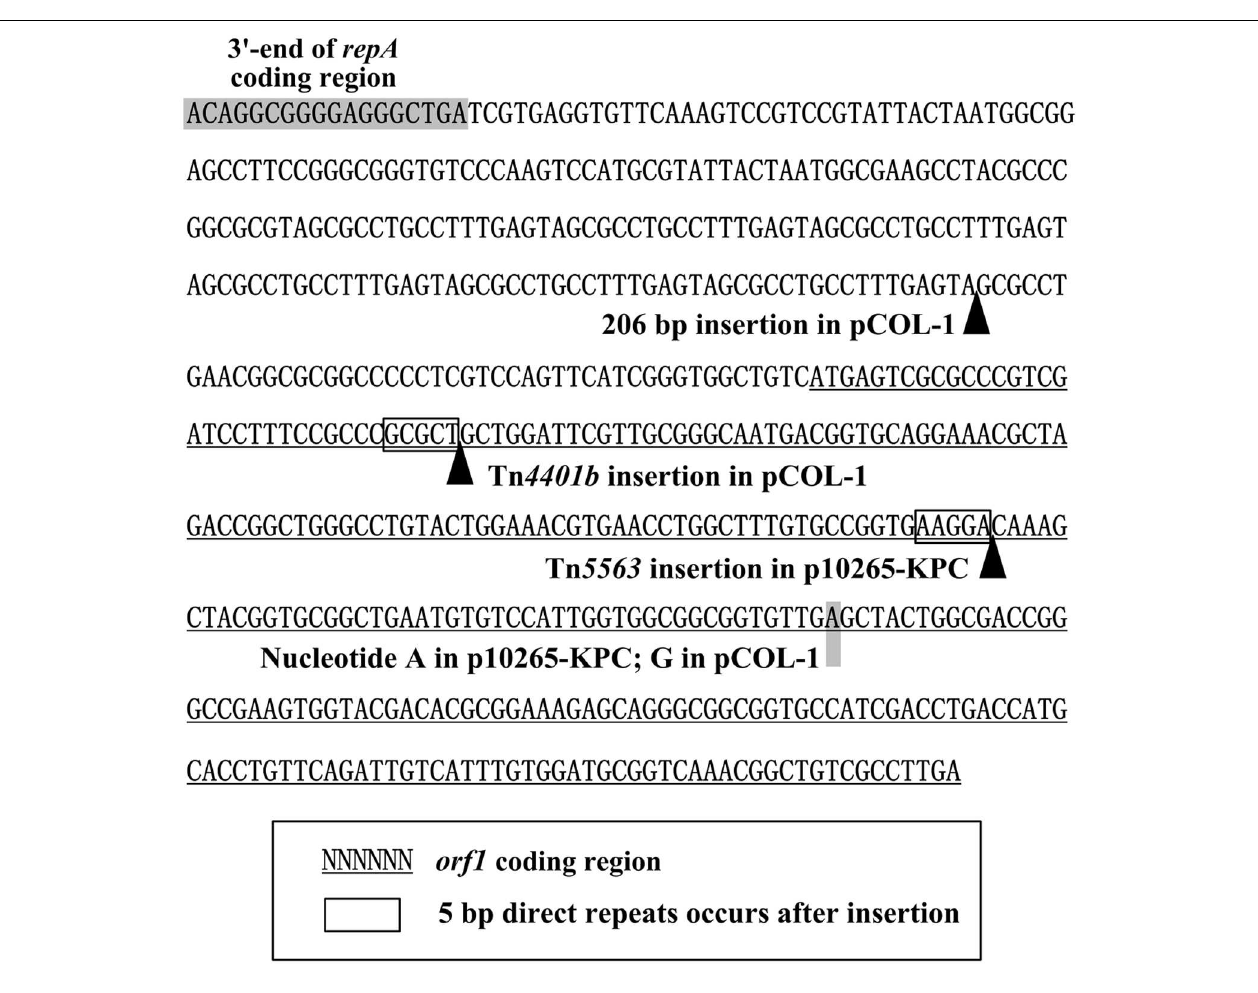
FIGURE 4 | orf1 -surrounding regions. Shown are the orf1 -surrounding DNA regions of p10265-KPC and pCOL-1 with inserted genetic